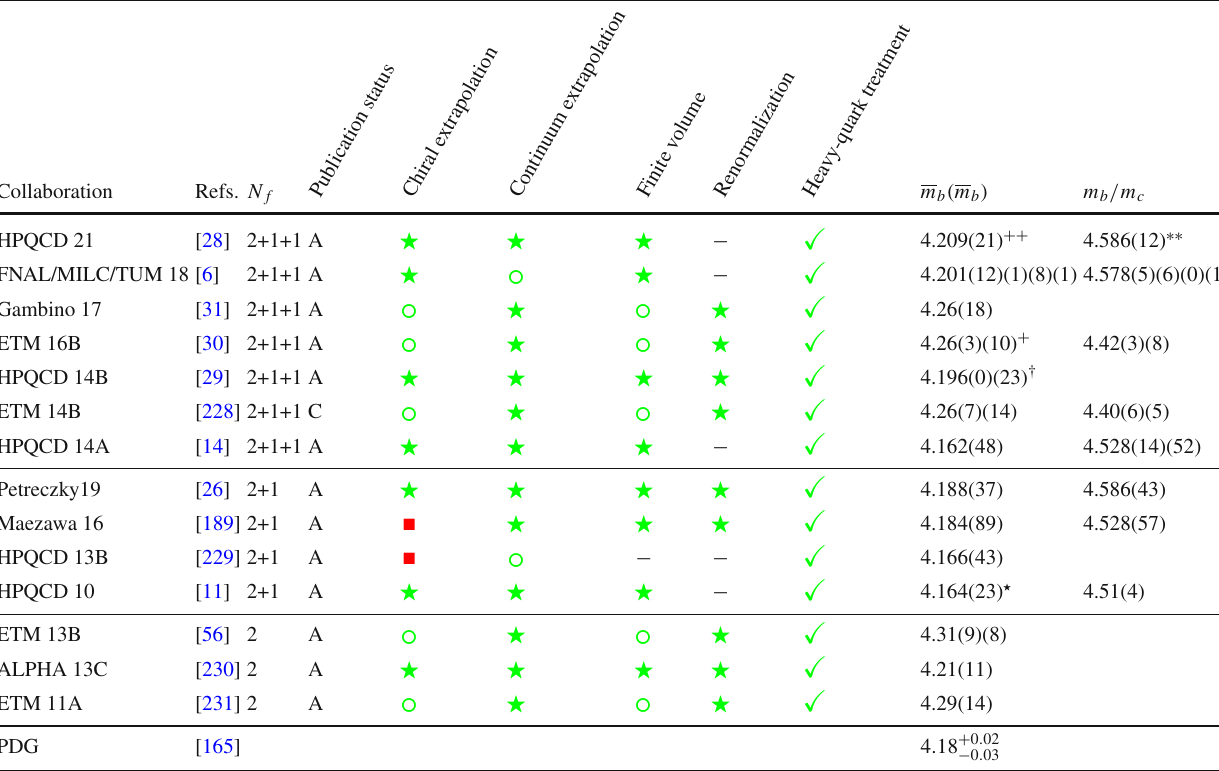
Table 14 Lattice results for the MS bottom-quark mass m b ( m b ) in GeV, together with the systematic error ratings for each. Available results for the quark-mass ratio m b / m c are also reported